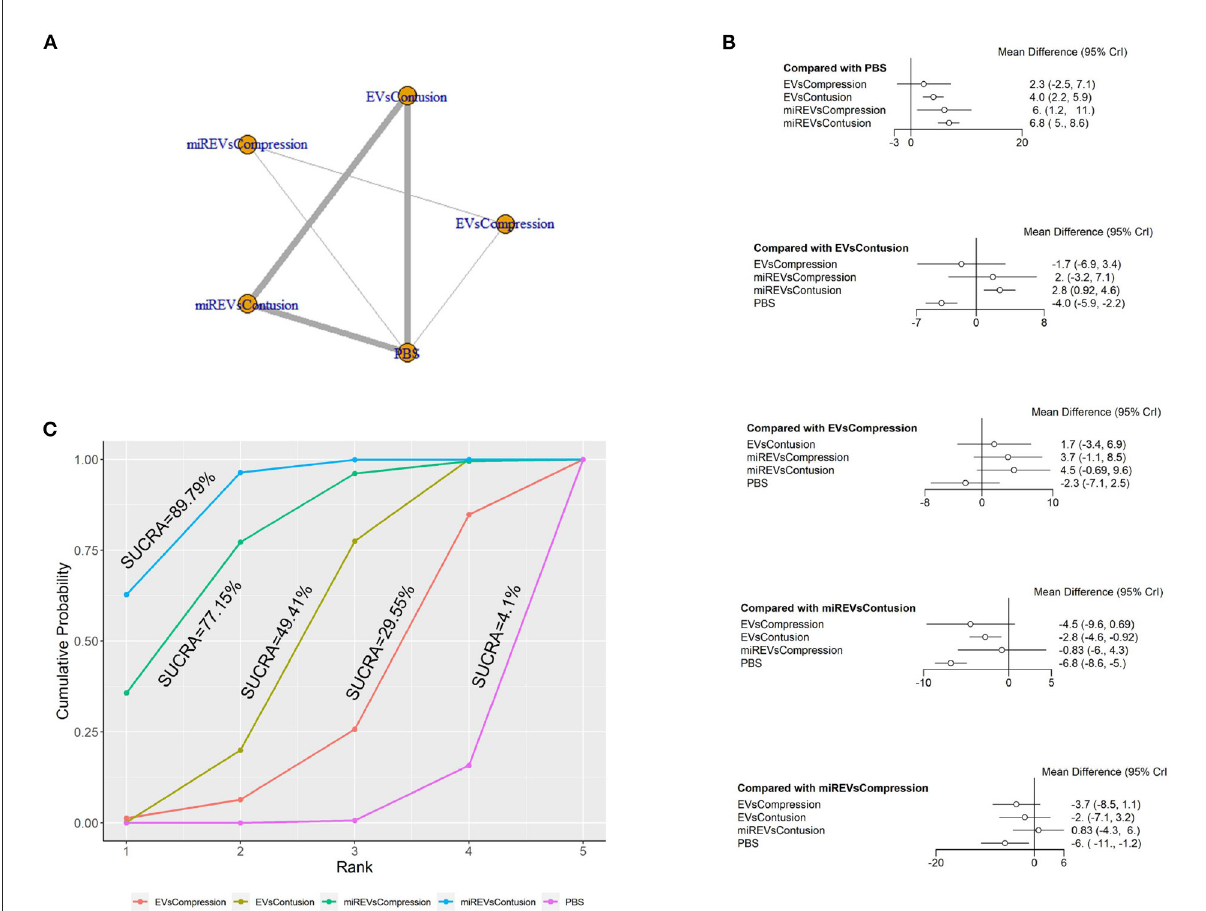
FIGURE9 The network meta-analysis of BBB scores in different models at 28 days after administration. (A) Network plot; (B) Forest plot; (C) SUCRA plot. EVsCompression, EVs in compression models; EVsContusion, EVs in contusion models; miREVsCompression, miRNAs-loaded EVs in compression models; miREVsContusion, miRNAs-loaded EVs in contusion